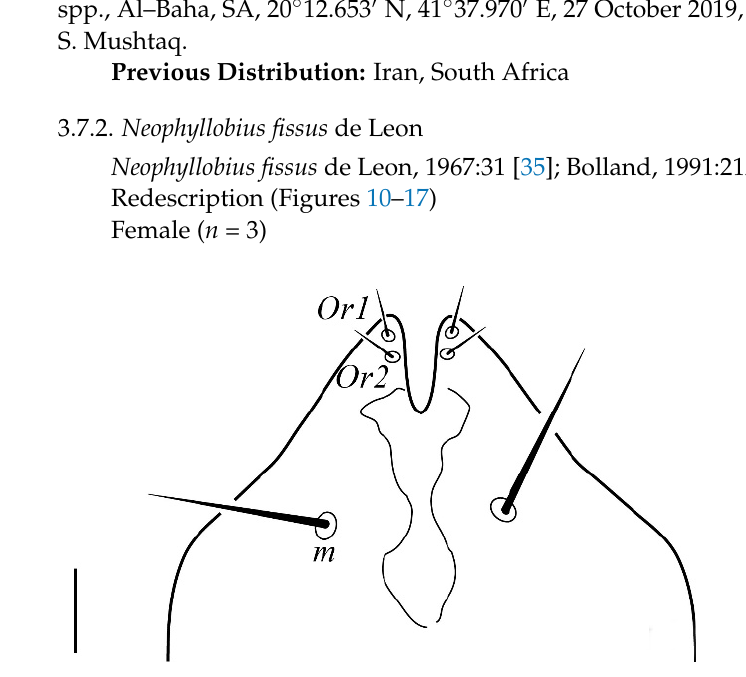
Figure 10. Neophyllobius fissus . Female. Gnathosoma. Scale bar: 20 μ m.